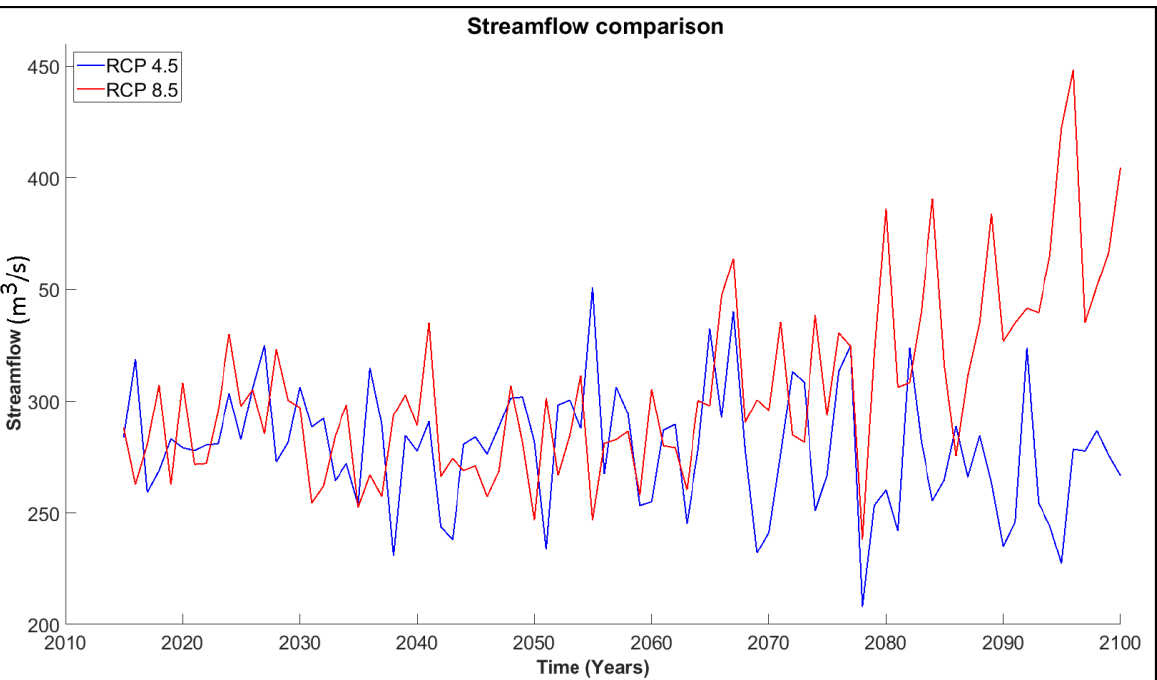
Figure 13. Comparison of simulated time series of streamflow at the basin outlet for both RCP 4.5 and 8.5 scenarios between 2011 and 2100 .